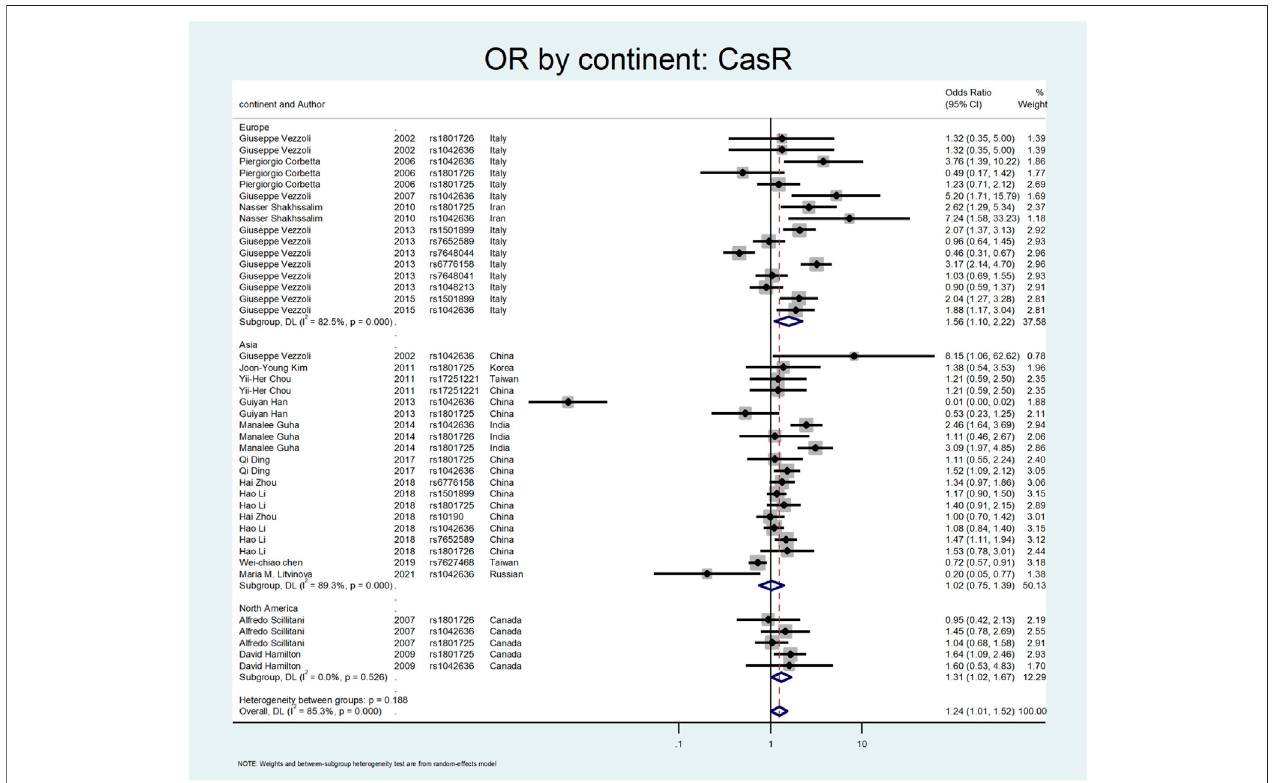
FIGURE 6 | Subgroup analysis for CASR, by